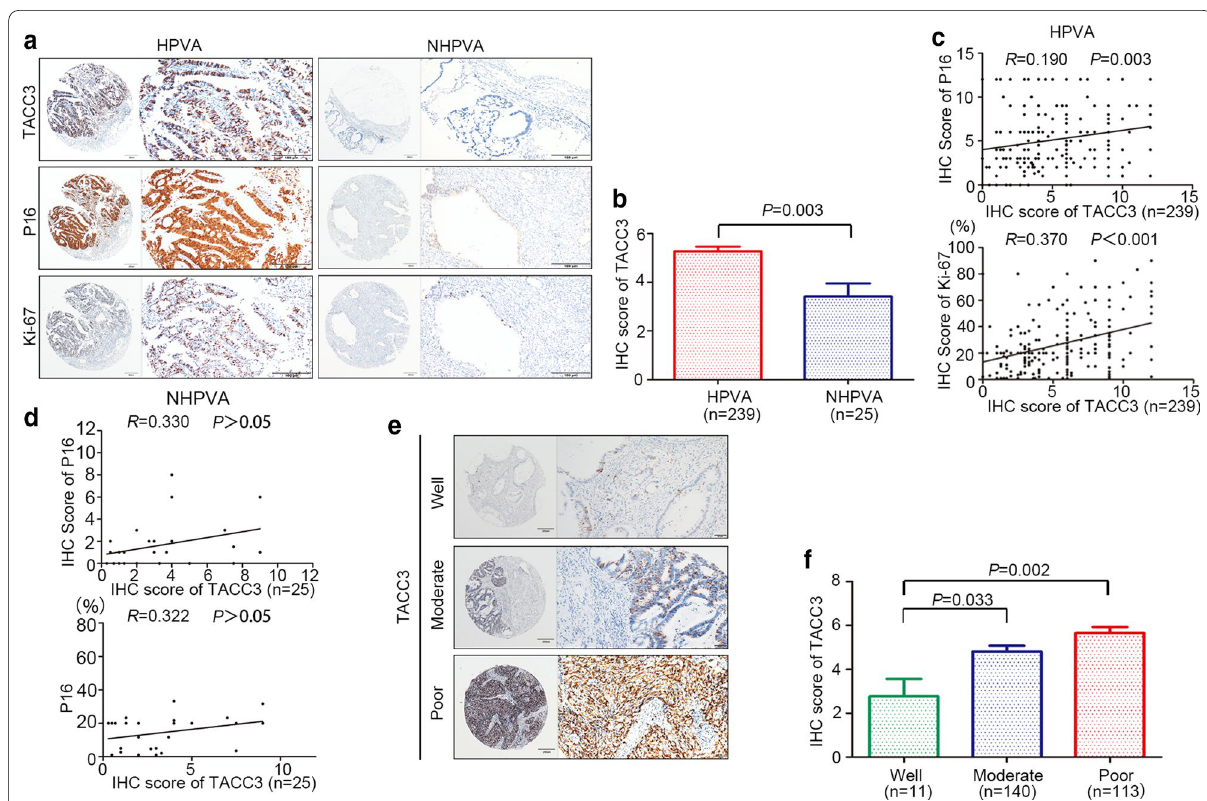
Fig. 2 Relationship between TACC3, , and Ki‑67 expression in human papillomavirus‑associated (HPVA) and non‑HPVA (NHPVA) cases. a Representative immunohistochemistry (IHC) staining for TACC3, P16, and Ki‑67 expression in HPVA and NHPVA. b According to the IHC scores of HPVA and NHPVA, TACC3 expression in HPVA was significantly higher than that in NHPVA. c Relationship between TACC3 expression and that of P16 and Ki‑67 in HPVA. d Relationship between TACC3 expression and that of P16 and Ki‑67 in NHPVA. e Representative images of TACC3 expression in well differentiated, moderately differentiated and poorly differentiated tumors. f Comparison of TACC3 levels in ell differentiated, moderately differentiated and poorly differentiated tumors. Quantitative data are presented as the mean standard deviation ±